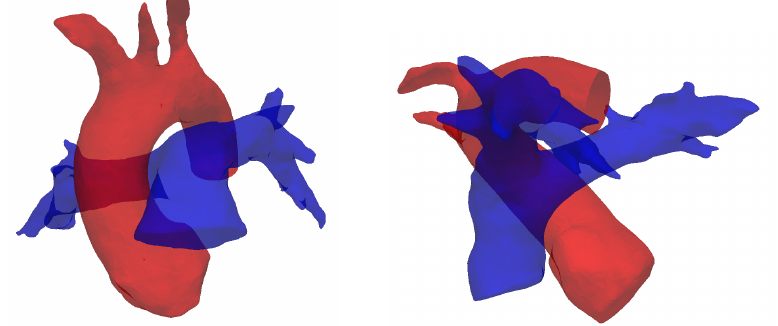
Figure 12. Spiral arrangement of the pulmonary artery (blue) and the aorta (red), shown by segmented reconstructions of the vessels for subject #5 (see Table 1). This configuration supposedly determines the characteristic curvatures observed in this study.